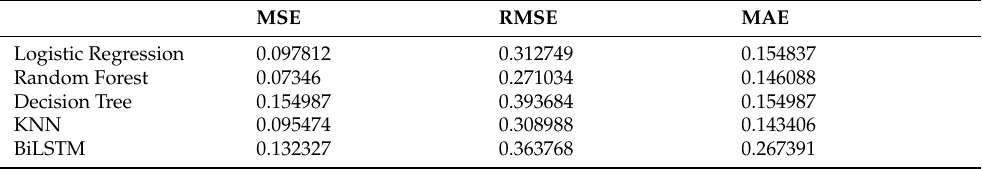
Table 6. Mean Squared Error (MSE), Root Mean Square Error (RMSE), and Mean Absolute Error (MAE) for scenario 4 with the regression method (Y = “Sentiment”). MSE RMSE